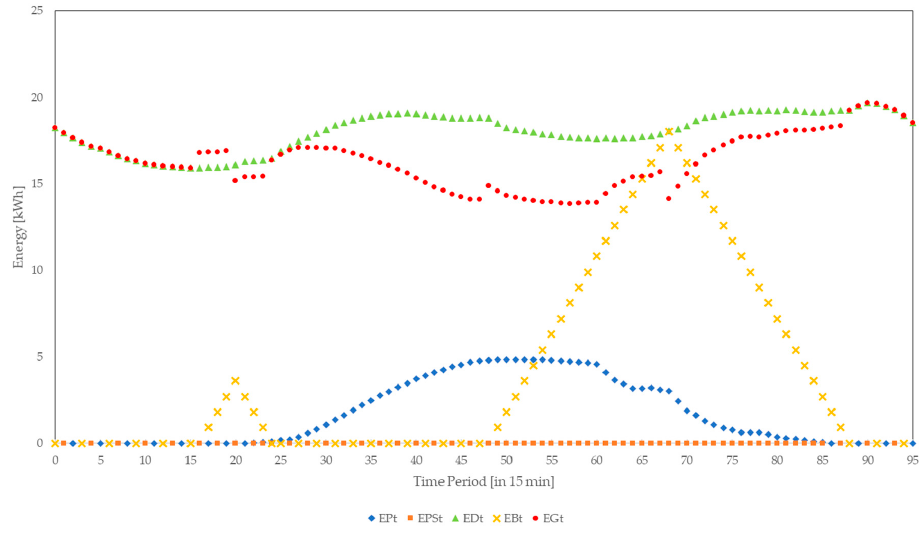
Figure 7. Graphic analysis of household simulation.